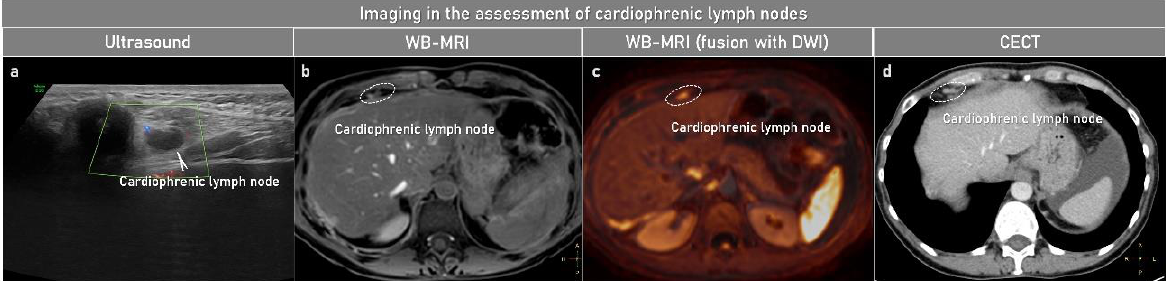
Figure 5. Demonstration of a patient with ovarian cancer (FIGO stage IVB) with pleural parietal carcinomatosis. Sagittal ultrasound images showing left parietal pleural carcinomatosis and hydrothorax ( a ), with corresponding axial WB-MRI (CE-T1WI-FS) ( b ) and CECT ( c ). CECT, contrast enhanced computed tomography; CE-T1WI-FS, contrast-enhanced T1-weighted imaging with fat suppression; FIGO, International Federation of Gynecology and Obstetrics; WB-MRI, whole-body magnetic resonance imaging.